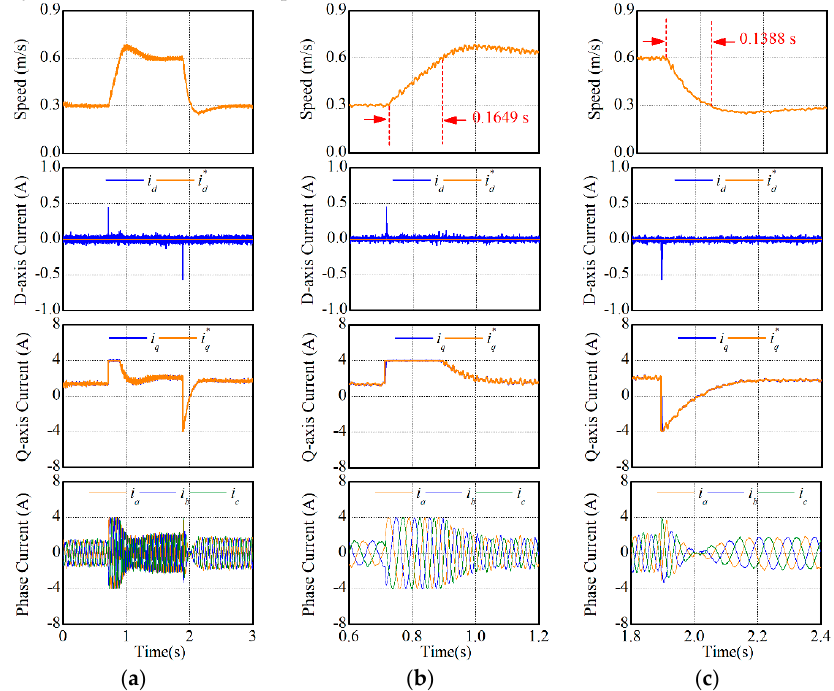
Figure 9. Speed response performances of MPCC-I. ( a ) t = 0–3 s, ( b ) t = 0.6–1.2 s, and ( c ) t = 1.8–2.4 s.